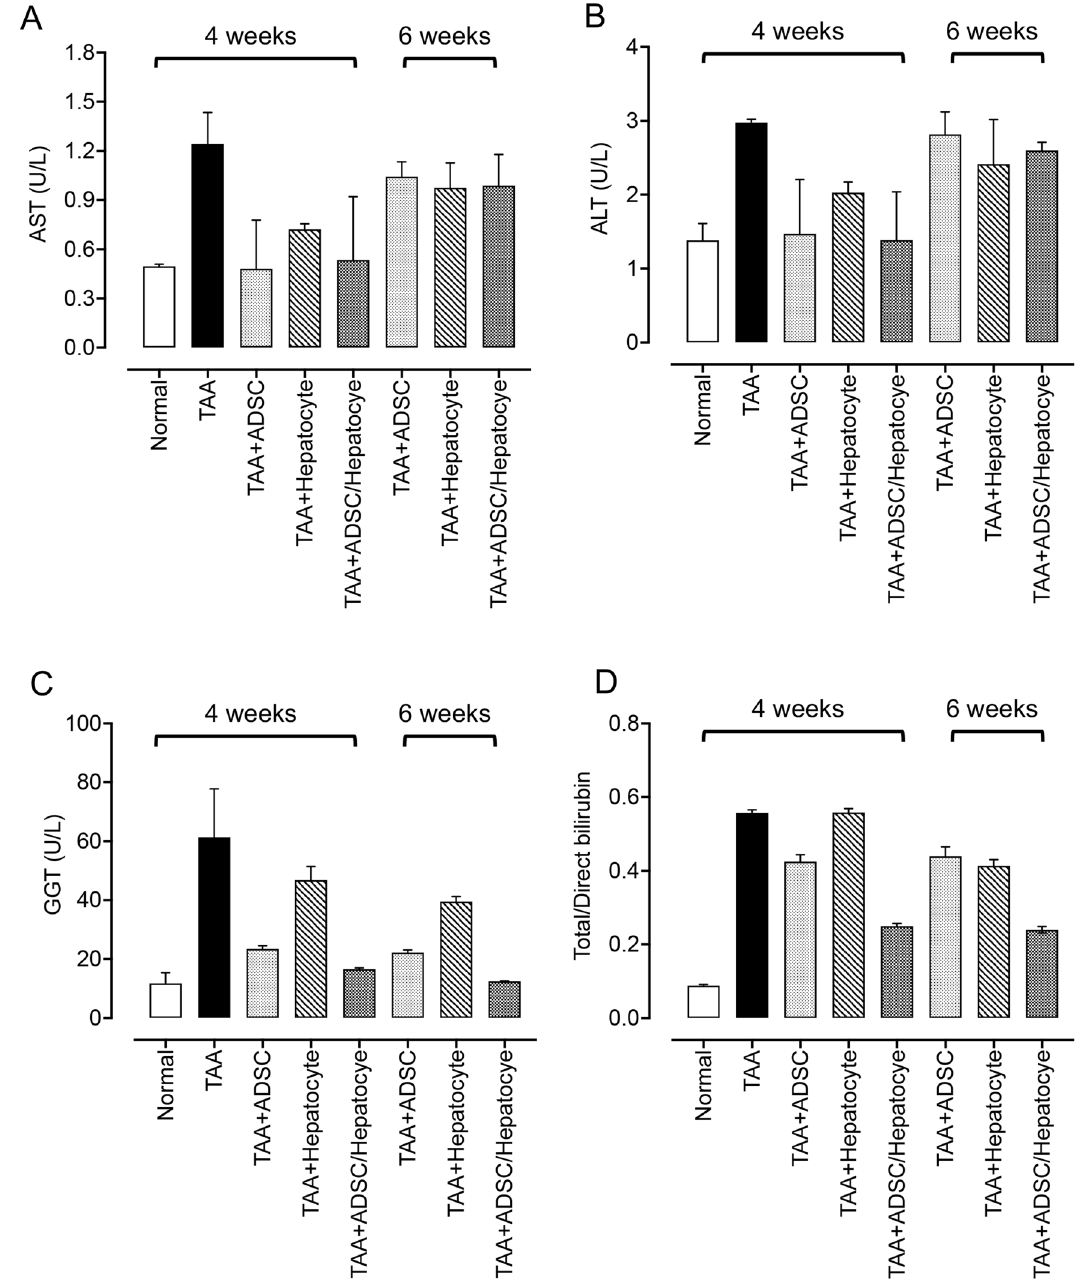
Figure 5. Serum biochemical data of ( A ) aspartate aminotransferase (AST), ( B ) alanine aminotransferase (ALT), ( C ) γ-glutamyltransferase (γ-GT), and ( D ) total/direct bilirubin in the experimental groups (n = 2 from 4 rats). Group data are shown as means ±